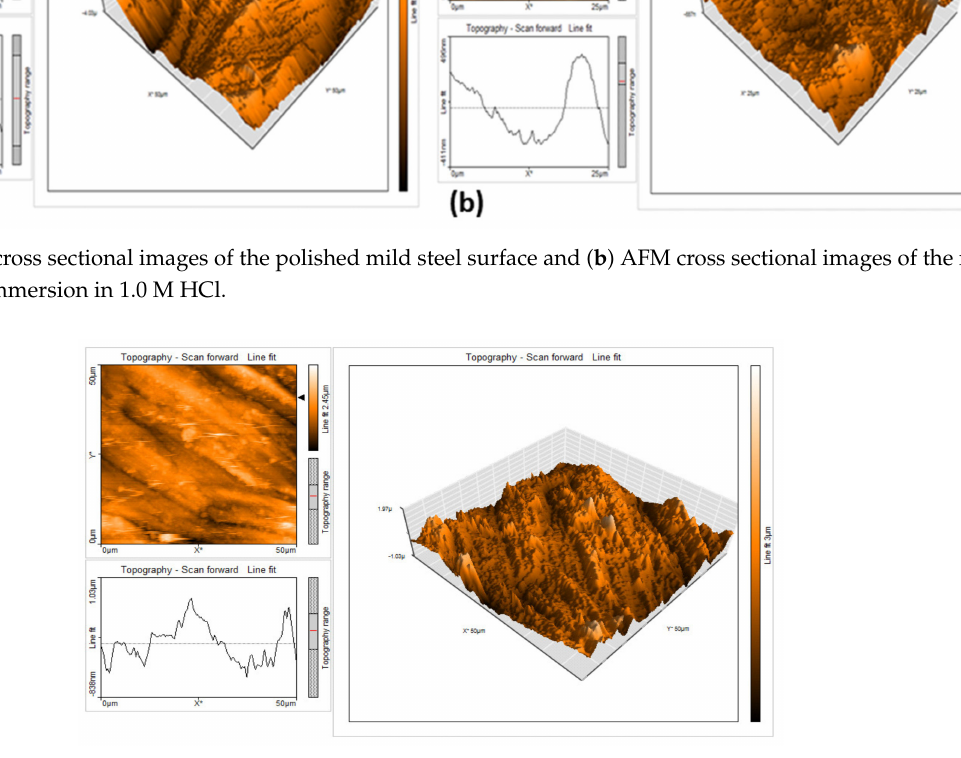
Figure 10. AFM cross sectional image for the mild steel surface after immersion in 1.0 M HCl with the 10% aqueous SA leaf extract. Table 11. AFM surface and line roughness data for different